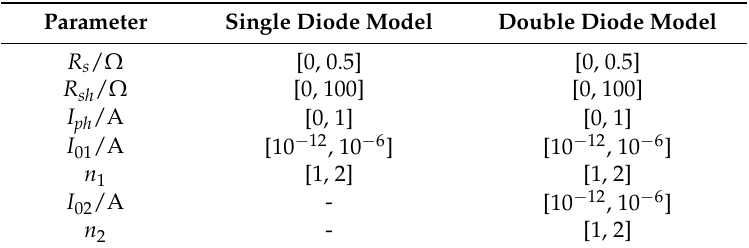
Table 1. Parameter bounds for single diode and double diode PV cell circuit.